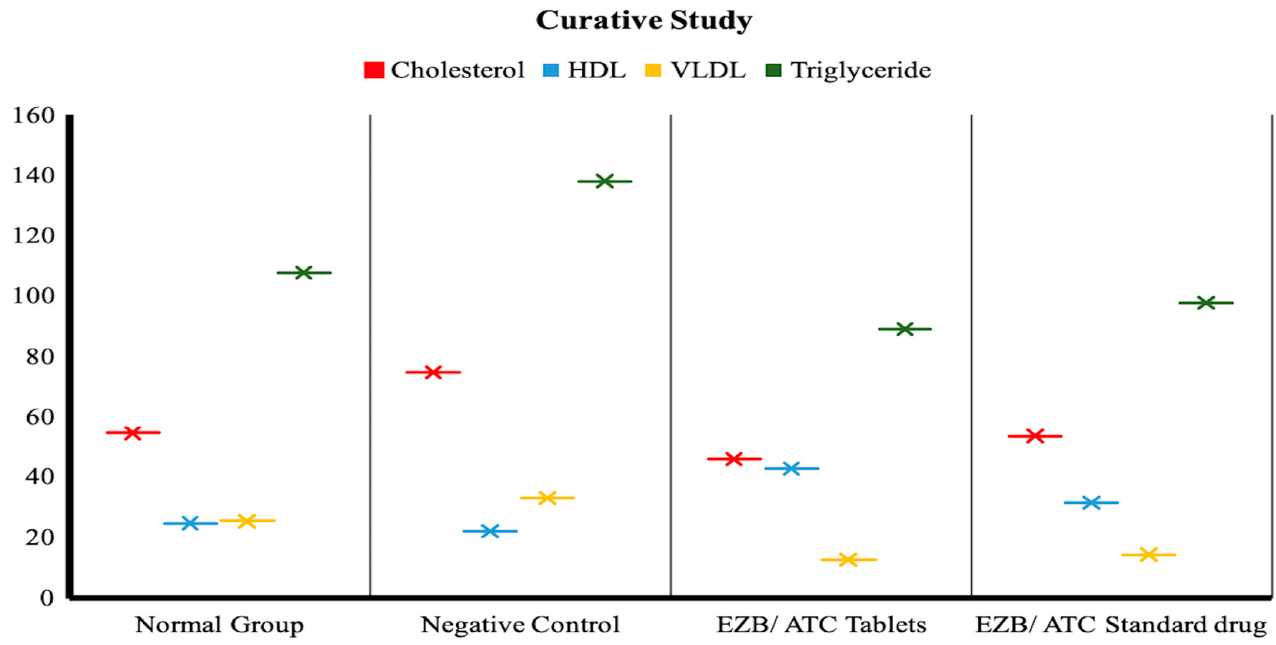
Figure 7. The effects of drugs on cholesterol, HDL, VLDL and triglycerides during curative treatment in normal group, negative control, EZB/ATC tablet group and EZB/ATC standard drug group.